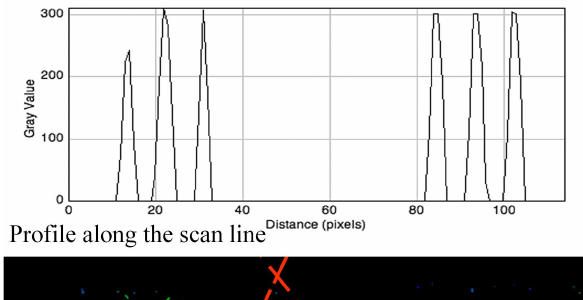
Figure 6. Runway, camera and image coordinate